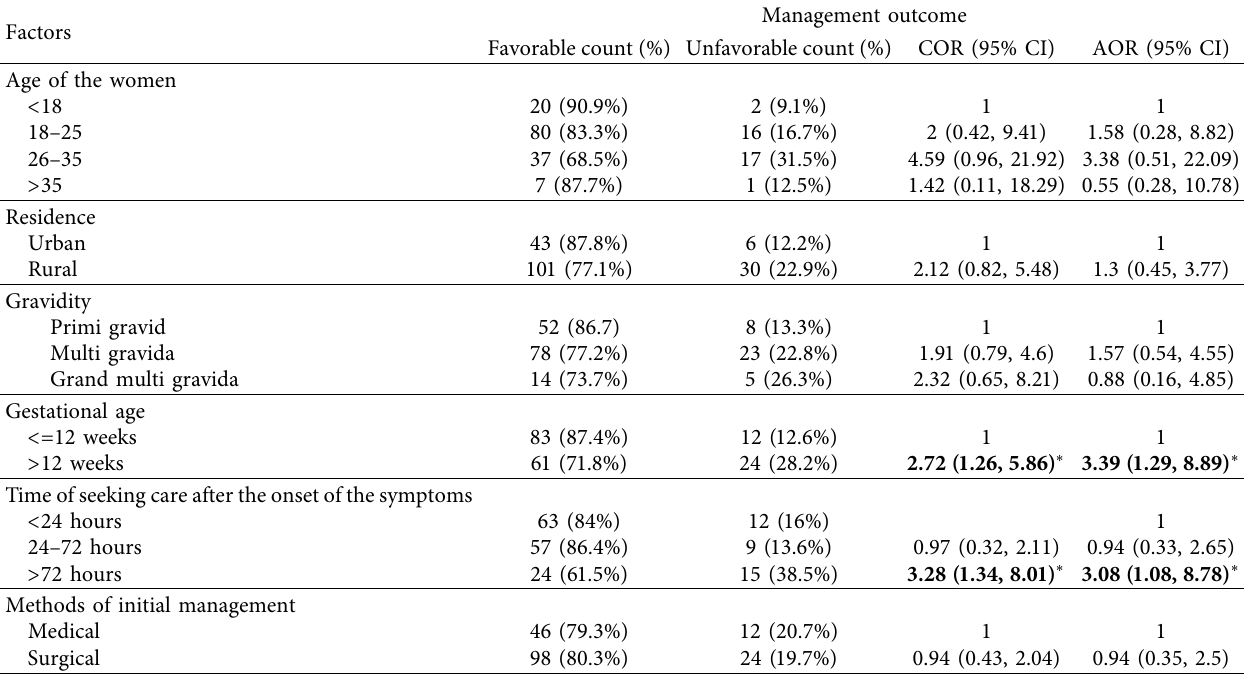
Table 3: Multivariate analysis result of factors affecting management outcomes of incomplete abortion among in Yirgalem